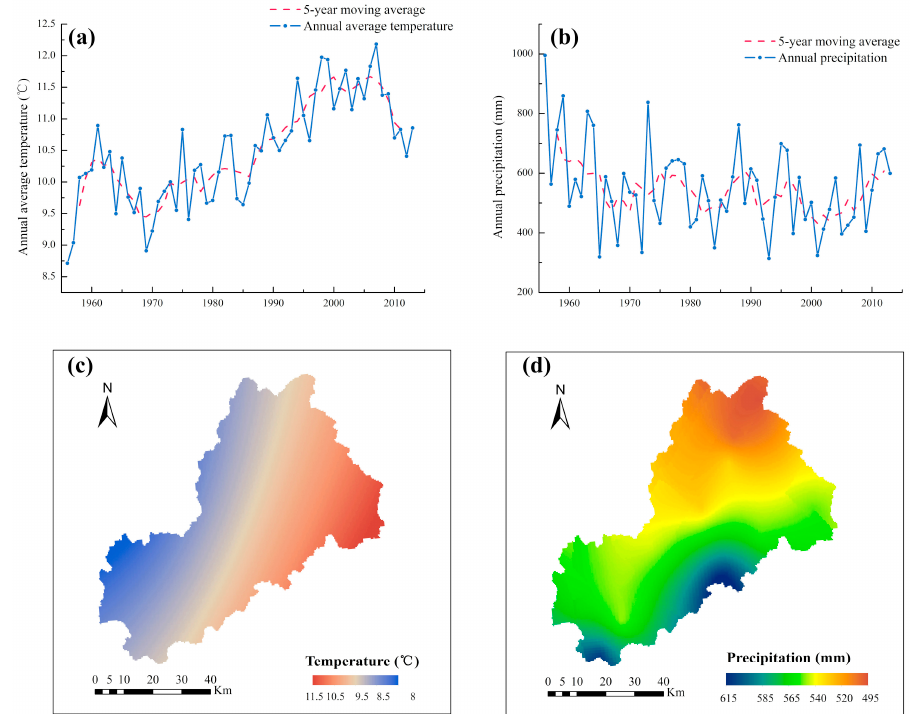
Figure 10. Time series of annual average temperature ( a ) and annual precipitation ( b ) during 1961–2013, and the spatial distribution of annual average temperature ( c ) and annual precipitation ( d ) in the Juma River basin.